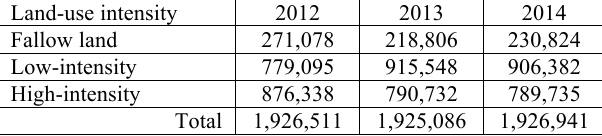
Table 2. Land-use intensity levels of cropland during the Rabi season in the south of Bangladesh in ha. Data were derived based on an analysis of Landsat 7 and 8 images and ground truth data collected by agronomists.